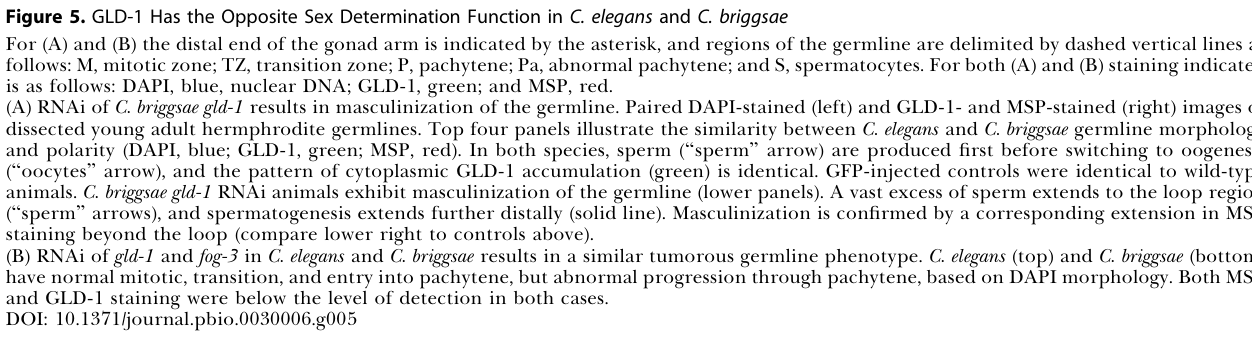
Figure 5. GLD-1 Has the Opposite Sex Determination Function in C. elegans and C. briggsae For (A) and (B) the distal end of the gonad arm is indicated by the asterisk, and regions of the germline are delimited by dashed vertical lines as follows: M, mitotic zone; TZ, transition zone; P, pachytene; Pa, abnormal pachytene; and S, spermatocytes. For both (A) and (B) staining indicated is as follows: DAPI, blue, nuclear DNA; GLD-1, green; and MSP, red. (A) RNAi of C. briggsae gld-1 results in masculinization of the germline. Paired DAPI-stained (left) and GLD-1- and MSP-stained (right) images of dissected young adult hermphrodite germlines. Top four panels illustrate the similarity between C. elegans and C. briggsae germline morphology and polarity (DAPI, blue; GLD-1, green; MSP, red). In both species, sperm ( ‘‘ sperm ’’ arrow) are produced first before switching to oogenesis ( ‘‘ oocytes ’’ arrow), and the pattern of cytoplasmic GLD-1 accumulation (green) is identical. GFP-injected controls were identical to wild-type animals. C. briggsae gld-1 RNAi animals exhibit masculinization of the germline (lower panels). A vast excess of sperm extends to the loop region ( ‘‘ sperm ’’ arrows), and spermatogenesis extends further distally (solid line). Masculinization is confirmed by a corresponding extension in MSP staining beyond the loop (compare lower right to controls above). (B) RNAi of gld-1 and fog-3 in C. elegans and C. briggsae results in a similar tumorous germline phenotype. C. elegans (top) and C. briggsae (bottom) have normal mitotic, transition, and entry into pachytene, but abnormal progression through pachytene, based on DAPI morphology. Both MSP and GLD-1 staining were below the level of detection in both cases. DOI: 10.1371/journal.pbio.0030006.g005 oogenesis. Anti-GLD-1 antibody staining of gld-1 RNAi F1